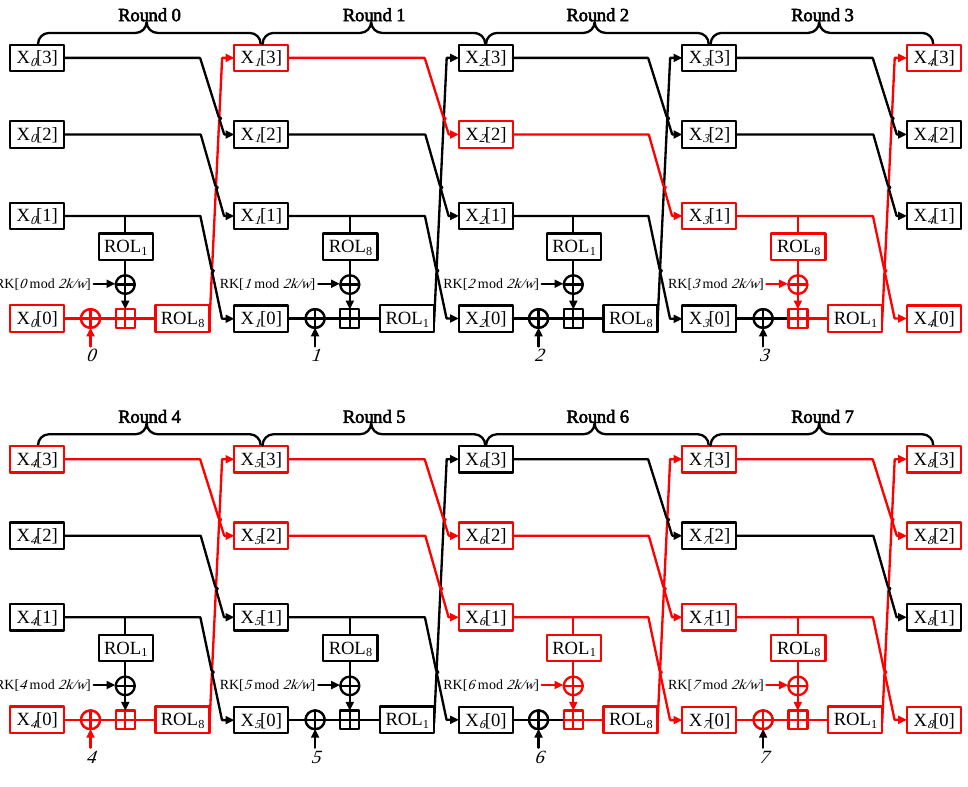
Figure 1. Path tracking for counter